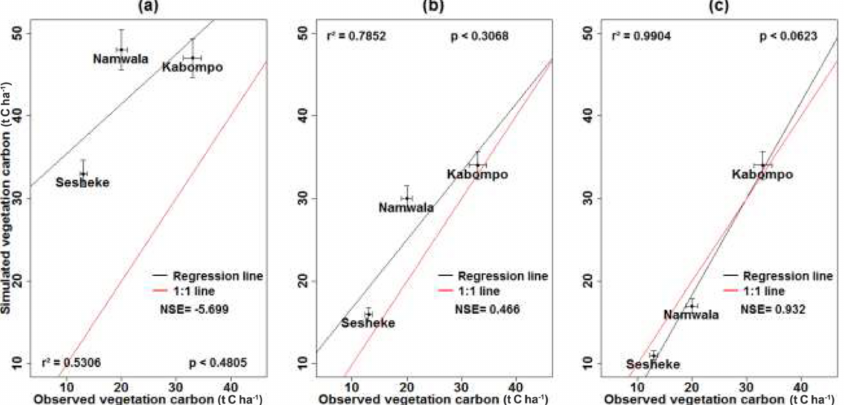
Figure 3. Measured versus LPJ-GUESS-simulated vegetation carbon stock simulated with default soil parameters, default tree parameters, and observed local climate (a) ; with local soil, local tree parameters, and observed local climate (b) ; and with local soil, local tree parameters, and modelled contemporaneous climate (c) . NSE stands for Nash–Sutcliffe efficiency (Nash and Sutcliffe,